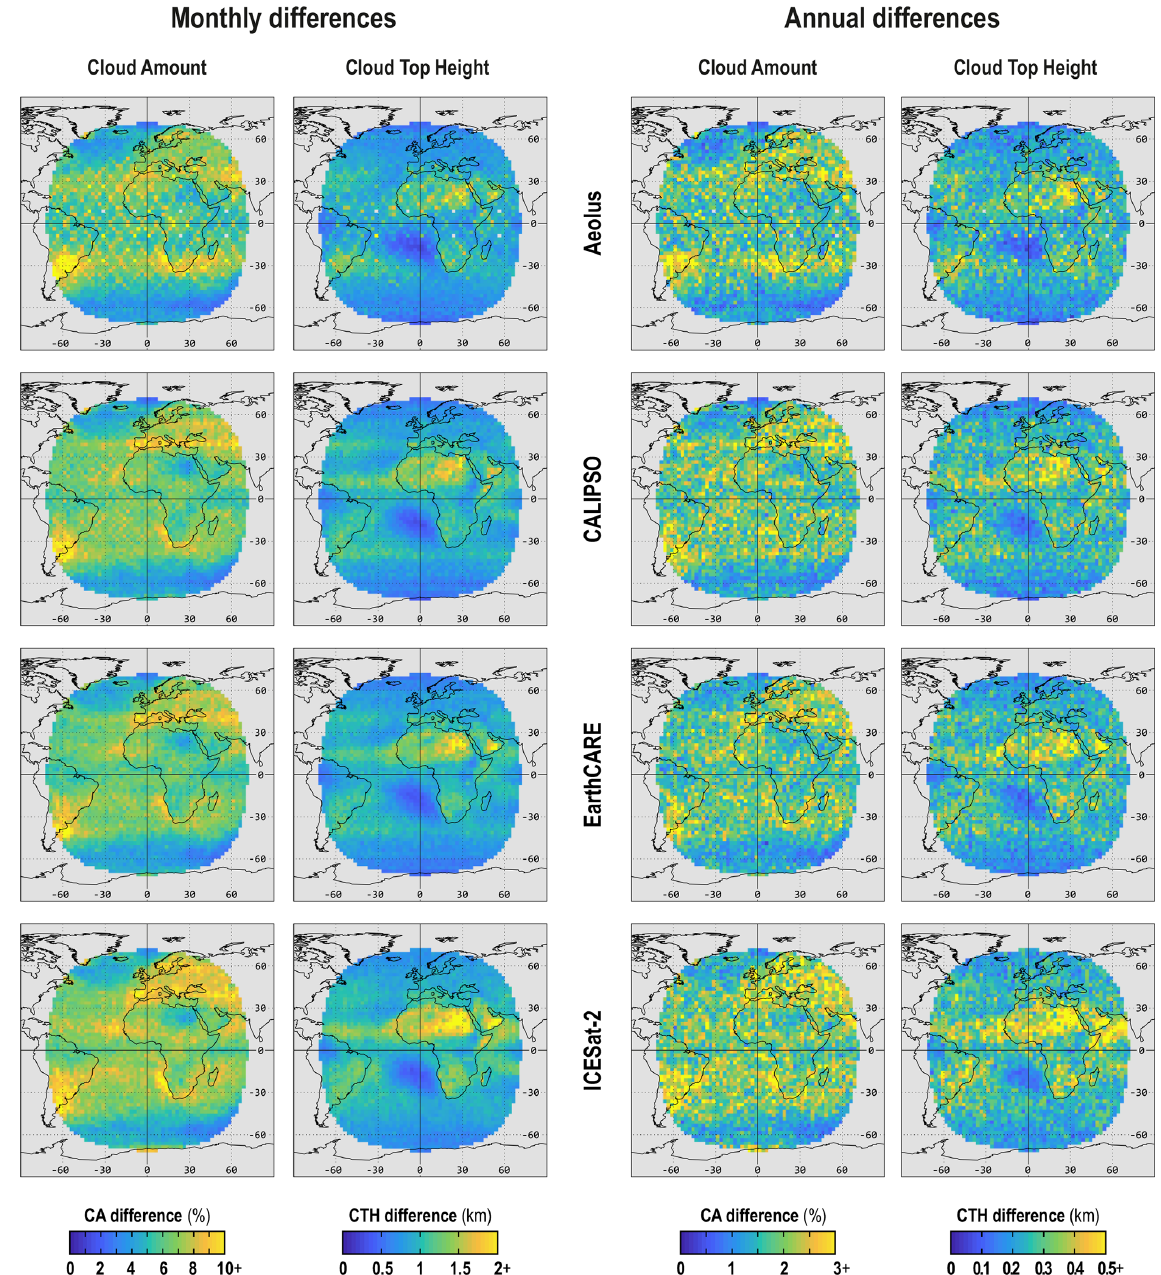
Figure 2. The geographical distribution of mean absolute differences between n day and 1d revisit cloud amounts, and cloud top heights at monthly mean (left panel), and annual mean (right panel) timescales. In all cases, n day values are subtracted from 1d values. Maps refer to 2.5 ◦